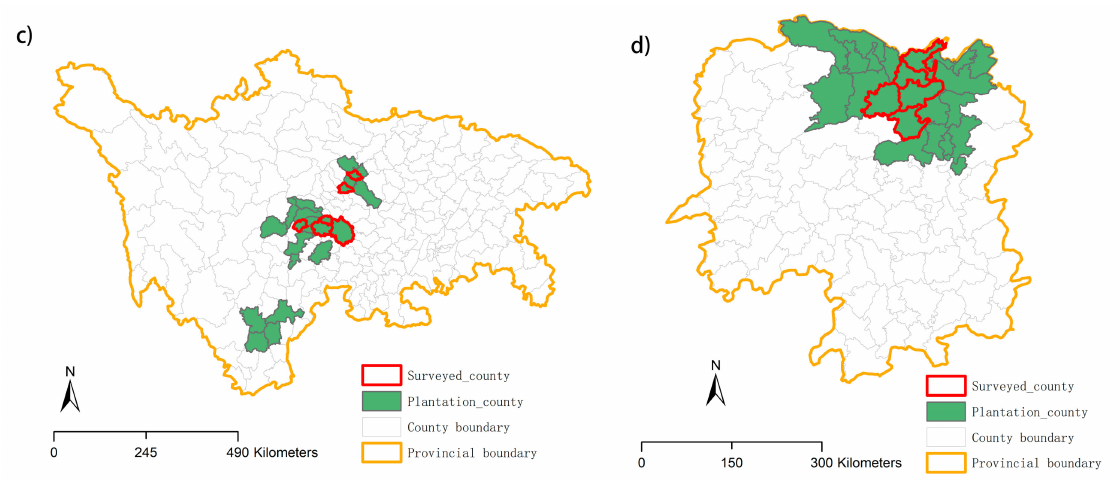
Figure 1. Study area. ( a ) Anhui province, ( b ) Hunan province, ( c ) Sichuan Province, and ( d ) Hubei